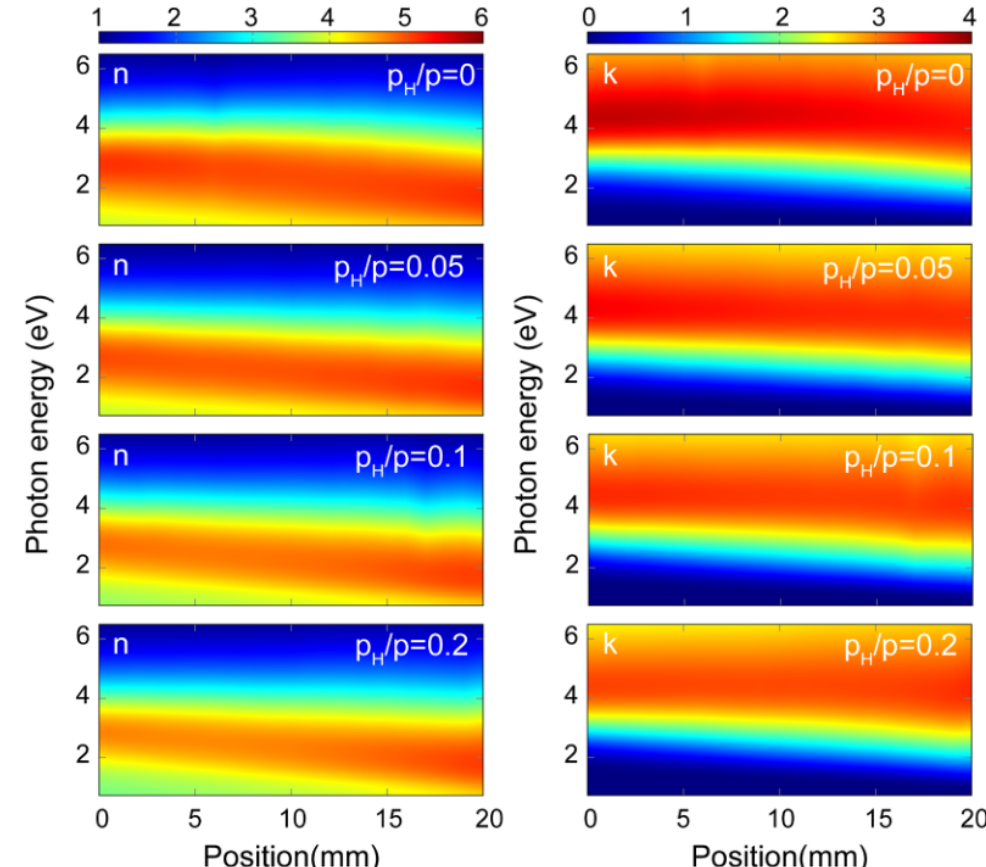
Figure 13. Color-coded maps of refractive index n ( left column ) and extinction coefficient k of hydrogenated amorphous SiGe films prepared at different H partial pressures (P H /P sputt = 0, 0.05, 0.1, and 0.2) as a function of position and photon energy measured by ellipsometry on µ -combinatorial samples. (The 0 mm position corresponds to the pure Si end of the sample.) Reproduced with permission from [60]. Copyright © 2020, Springer Nature.